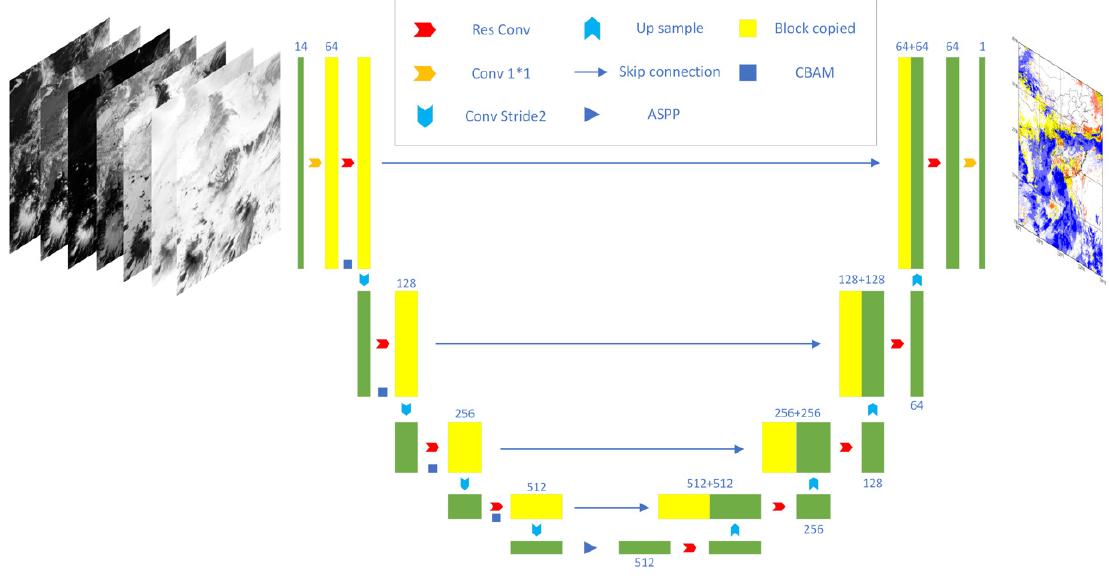
Figure 7. CLP-CNN network structure. As shown in Figure 7, the model structure is divided into encoder and decoder sections with four downsamples and four upsamples, respectively, corresponding to the left and right sides in Figure 7. In the encoder section, the input data are preprocessed FY-4A observation images containing 14 × 800 × 800 pixels. The data are adjusted for the number of data channels by means of a 1 × 1 convolutional layer, which avoids causing information loss at the input layer. The encoder section contains a Res-Conv unit in each layer,